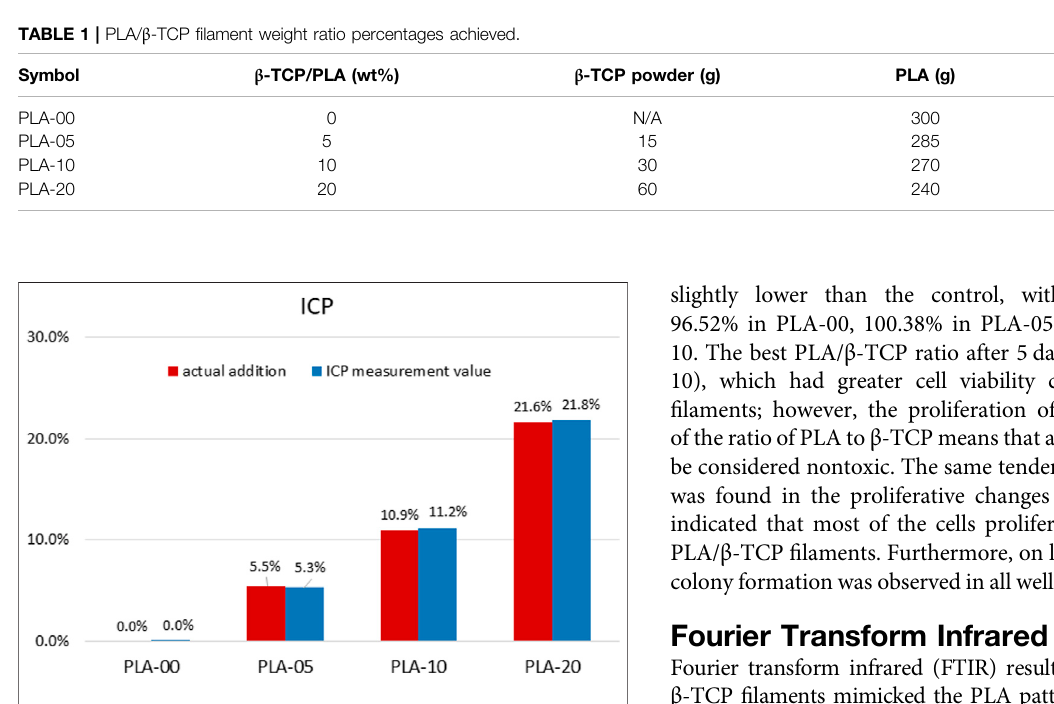
Frontiers in Materials |